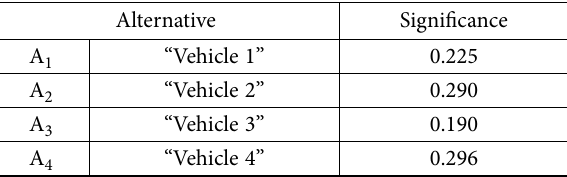
Table 4. Alternative ranking obtained by AHP method